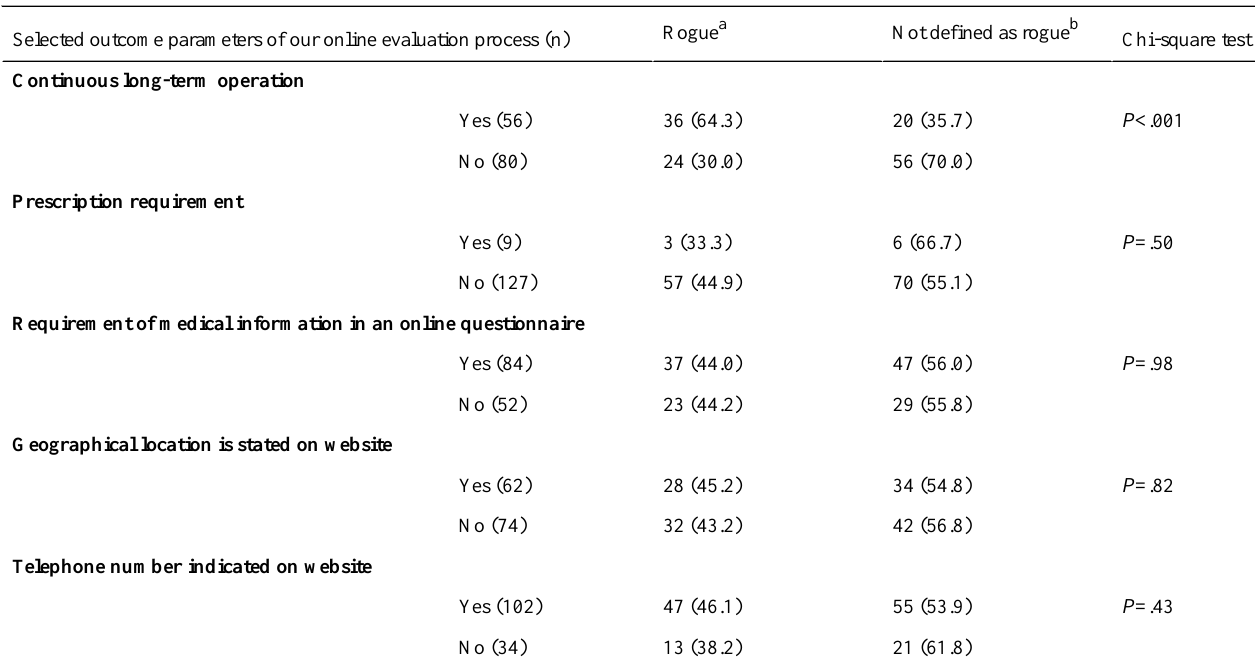
b Rogue a Chi-square testNot defined as rogue